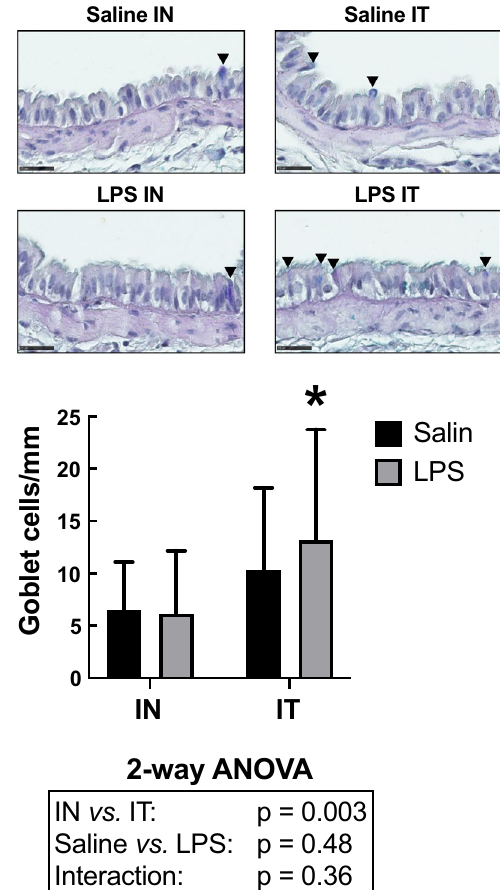
Figure 4. Number of goblet cells per mm of basement membrane. The upper panels are representative lung sections derived from mice treated with either saline (top) or LPS (bottom) through either the intranasal (IN) or the intratracheal (IT) route. The bar graph below depicts the mean in each group. Scale bars are 25 µm. The results of the two-way ANOVA are shown at the bottom of the graph. *Indicates statistically significant from the IN-exposed group treated with LPS. n = 18 per group and the data shown are means ±